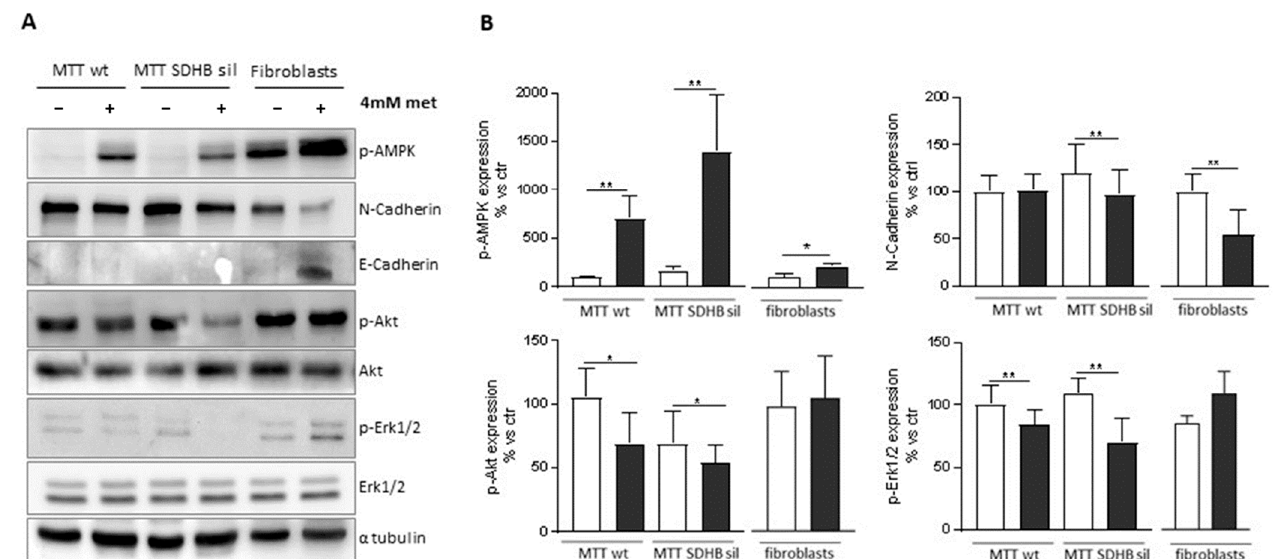
Figure 7. Effect of metformin on activation of intracellular signalling pathways in MTT and fibroblast cells. ( A ) Representative western blot of expression levels of Phospho-AMPK, Phospho-AKT, AKT, Phospho-ERK1/2, ERK1/2, N-Cadherin and E-Cadherin in MTT wt, MTT SDHB sil and fibroblasts treated or not with 4 mM of metformin for 72 h. α -tubulin immunoblot was used as loading control. ( B ) Densitometric analysis of Phospho-AMPK, Phospho-AKT, AKT, Phospho-ERK1/2, ERK1/2, N-Cadherin and E-Cadherin in MTT wt, MTT SDHB sil and fibroblasts treated (dark grey bars) or not (white bars) with 4 mM of metformin for 72 h. Graph bars indicate the mean of three independent experiments ± SD. Asterisks indicate significance (* p < 0.01; ** p < 0.01) by one tailed paired t -test.